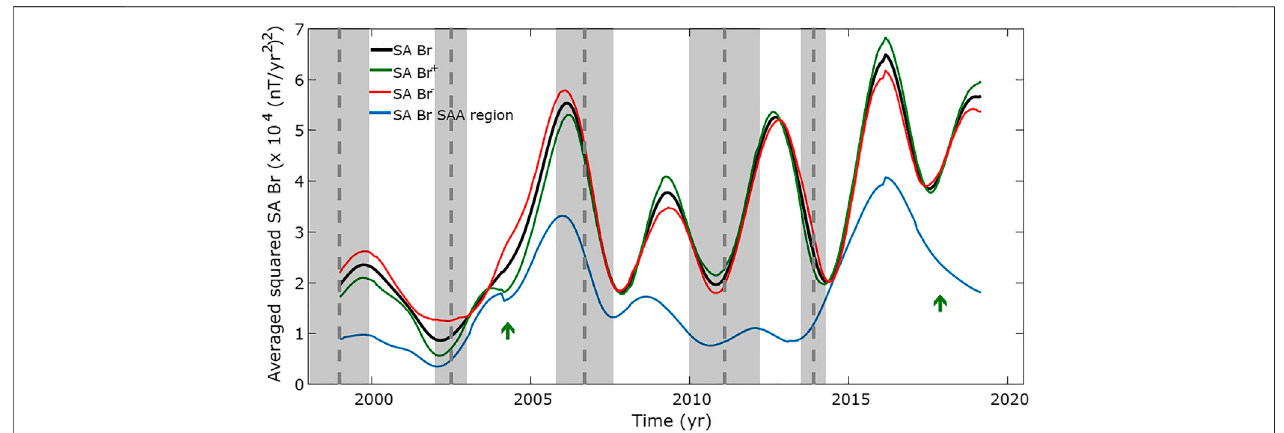
FIGURE 4 | Averaged secular acceleration of the geomagnetic fi eld at the CMB. Time variation of the averaged squared secular acceleration of the Br calculated using maximum spherical harmonic degree six at the CMB. In black, the average is calculated globally. In green, we consider only positive lobes of the SA of Br for average. In red, we consider only negative lobes of the SA of Br. In blue, we consider the SA of Br in the region where the RFPs associated with the SAA at surface are located at the CMB (between 20 ° S and 70 ° S in latitude and between 90 ° W and 70 ° E in longitude). In dashed vertical gray lines, the mean occurrence times of the well-de fi ned geomagnetic jerks for the last 2 decades are marked. Shaded bands mark the uncertainty of the occurrence times given by one standard deviation. With green arrows other interesting features are indicated (see Discussion in the main text for more details).